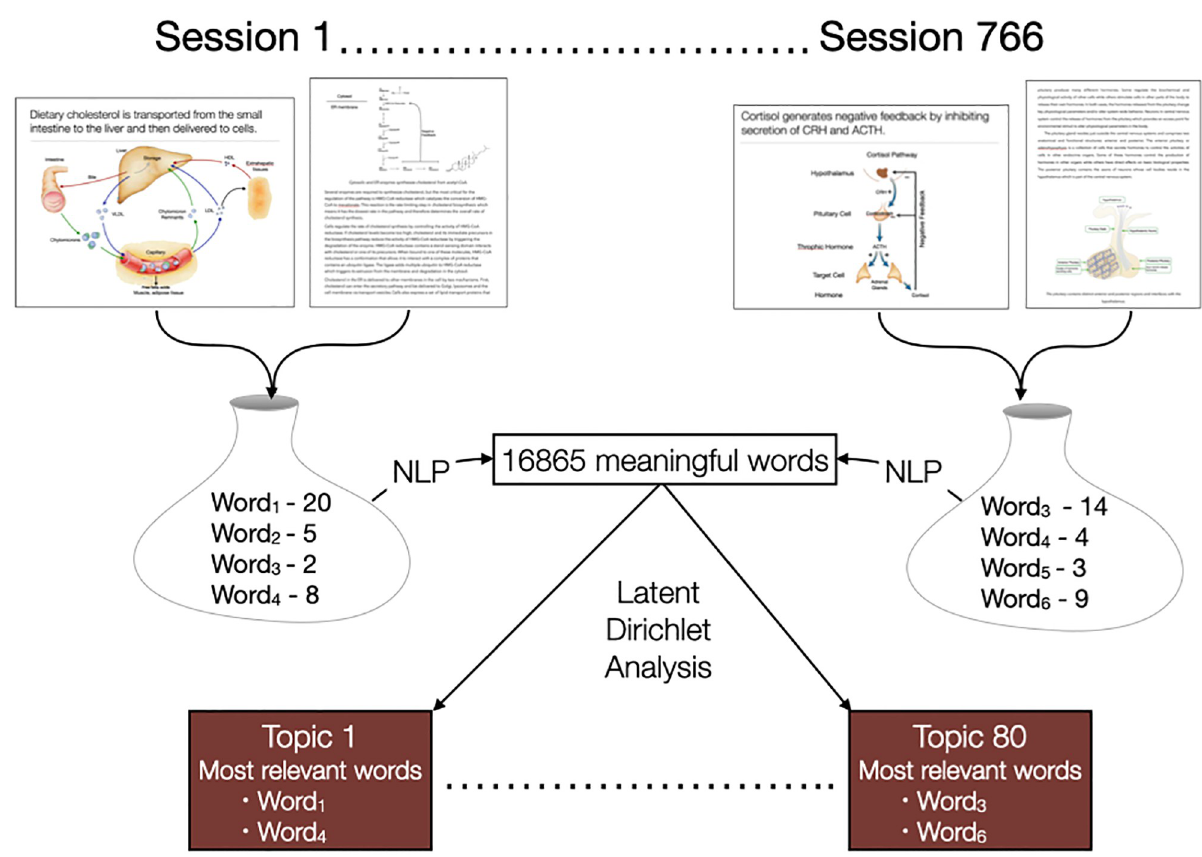
Fig 1. Extraction and processing of text from curricular documents. Slides, notes, and other documents were collected for every session in the pre- clerkship curriculum for one medical school class. Text was extracted from the documents using PDF Miner. Text from documents for the same session was combined and then processed to remove non-alphanumerical characters and common words, resulting in a collection of meaningful words. The LDA mallet library was used to generate a topic